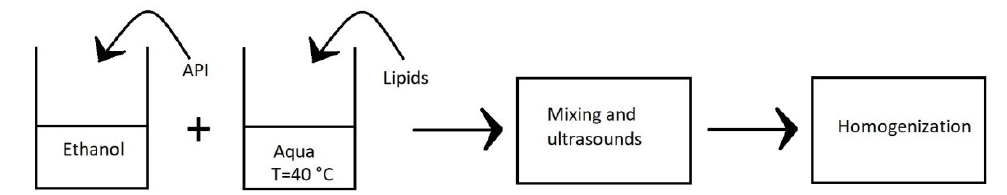
Figure 4. The hot method. API—Active Pharmaceutical Ingredient.